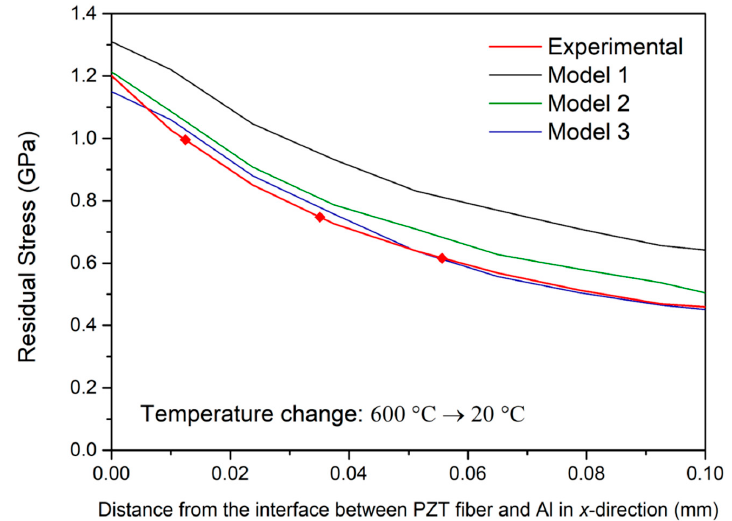
Figure 13. Compressive residual stress distribution along the x direction at y = z = 0 mm of three models and the experiment .